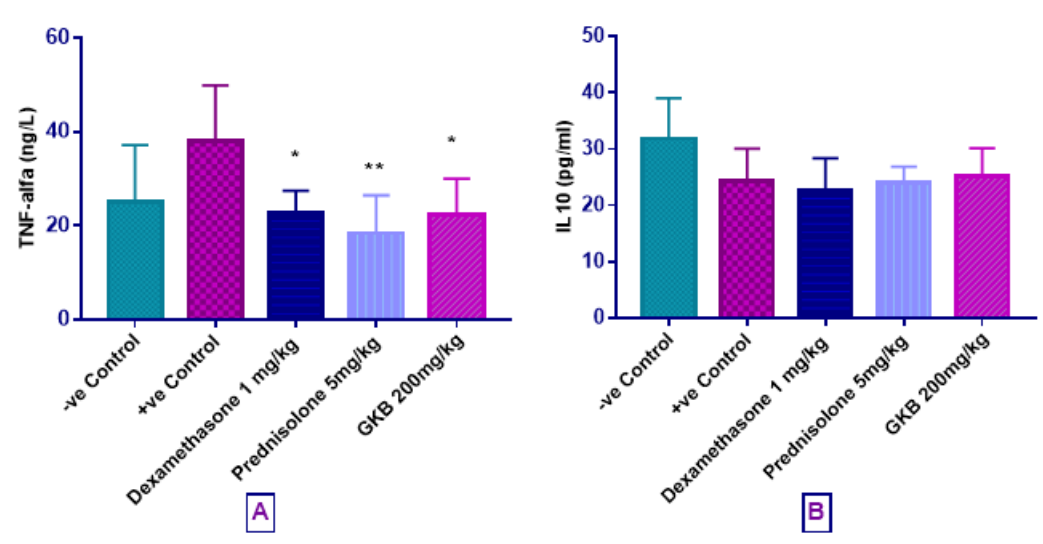
Figure 3. Effects of GKB extract on the inflammatory markers TNF-alfa (A) and IL10 (B) in granuloma model of inflammation. Values were presented as mean ± S.D (n= 6 animals in each group); values with (*) are significantly different from the positive control using ANOVA and post hoc test (* p < 0.05), and (** p < 0.01).